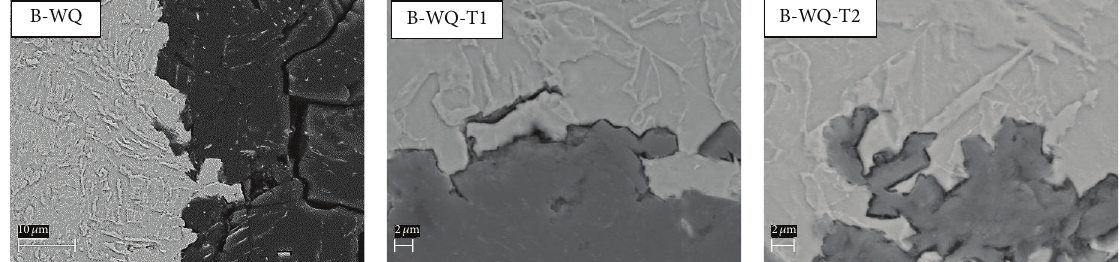
Figure 7: Scale morphology on quenched and tempered steels.